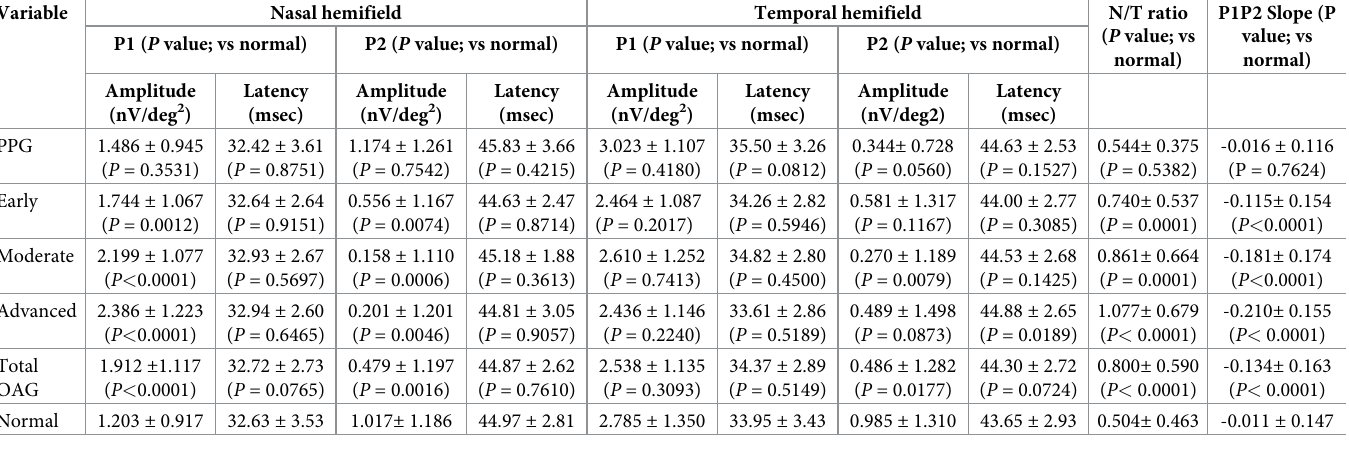
Table 2. Amplitudes of P1 and P2 of the mfERGs in the nasal and temporal hemifields. The P1 N/T amplitude ratio of the second-order kernel, P1P2 Slope of the nasal response of the second-order kernel. Variable